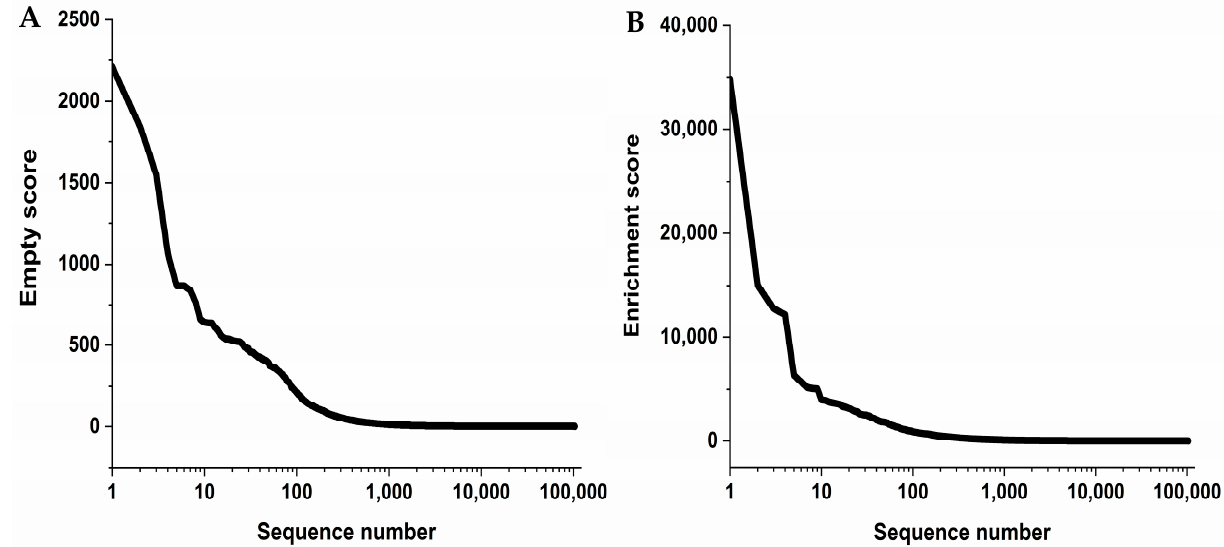
Figure 2. The selection yielded a small number of sequences with high empty or enrichment scores. The displayed distributions cover all sequences selected in a logarithmic scale on the x-axis. ( A ) After filtering with TSAT, every sequence was assigned an empty score. This score describes how much higher the frequency of a sequence of the last selection round is compared to its frequency within the control selection (empty selection). With the increasing empty score, the probability of a sequence to be target-specific rises as it is mainly enriched in the target selection. For this selection, we observed a minority of sequences having a very high empty score. Only sequences with an empty score of at least 250 were considered for further testing. ( B ) As with the empty score, an enrichment score was calculated and assigned to each sequence after filtering. This score describes the increase in frequency a sequence of the last target selection had compared to the library. The distribution of the enrichment score was very similar to the empty score, with a minority of sequences possessing a high score. Only sequences with an enrichment score of at least 250 were considered for further testing.